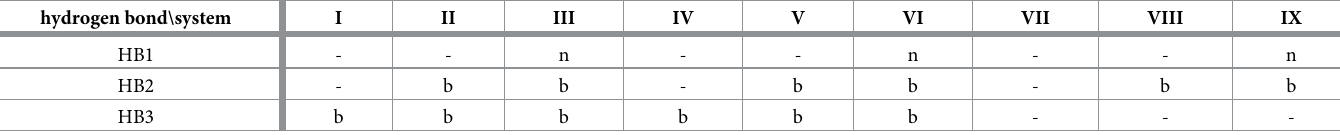
Table 1. List of intra-chain hydrogen bonds that must/must not be satisfied for the systems I–IX. The HB1 bond is defined as the hydrogen bond between the donor of the most N-terminal residue of the S1 strand in the system III, VI, or IX and the acceptor of the first residue of the GB loop. The HB2 and the HB3 bonds are defined as the � 0 and R N � 0 , respectively. The graphical explanations of HB1, HB2, and HB3 are given in S20 Fig. The symbol “b” hydrogen bonds required for the system of R N 1 (cid:0) 2 2 (cid:0) 2 0 means that it must be bonded, “-” means that its hydrogen bond is ignored because a given system does not include such a donor-acceptor pair, and “n” means that it must not be bonded. HB1 is “n” in the systems III, VI, and IX because if HB1 is formed, the N-terminus of S2 will be stretched by one residue; therefore, it will not be a required register shift for these